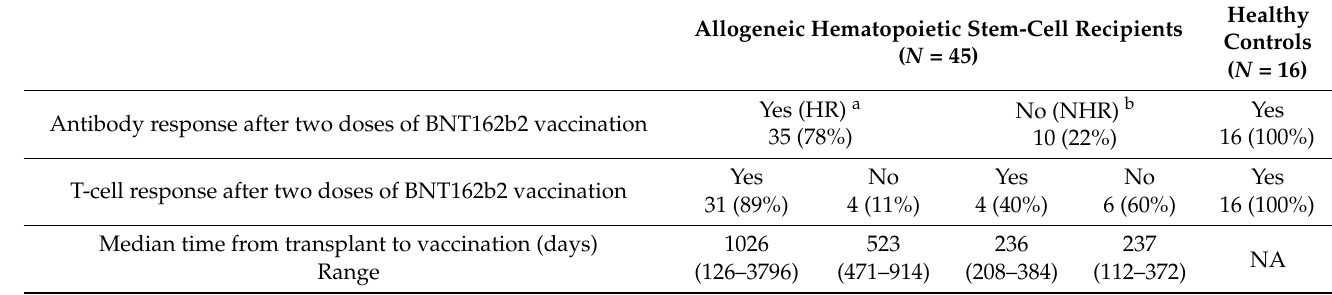
Table 1. Vaccinated individuals’